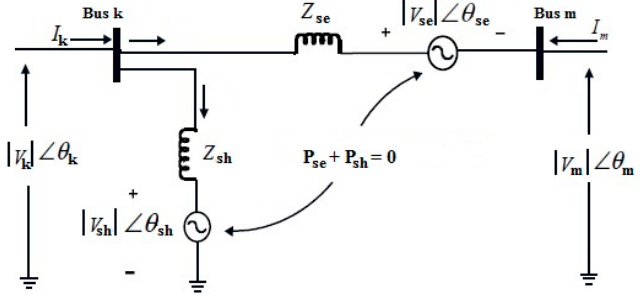
Figure 1. General Equivalent Circuit of UPFC.